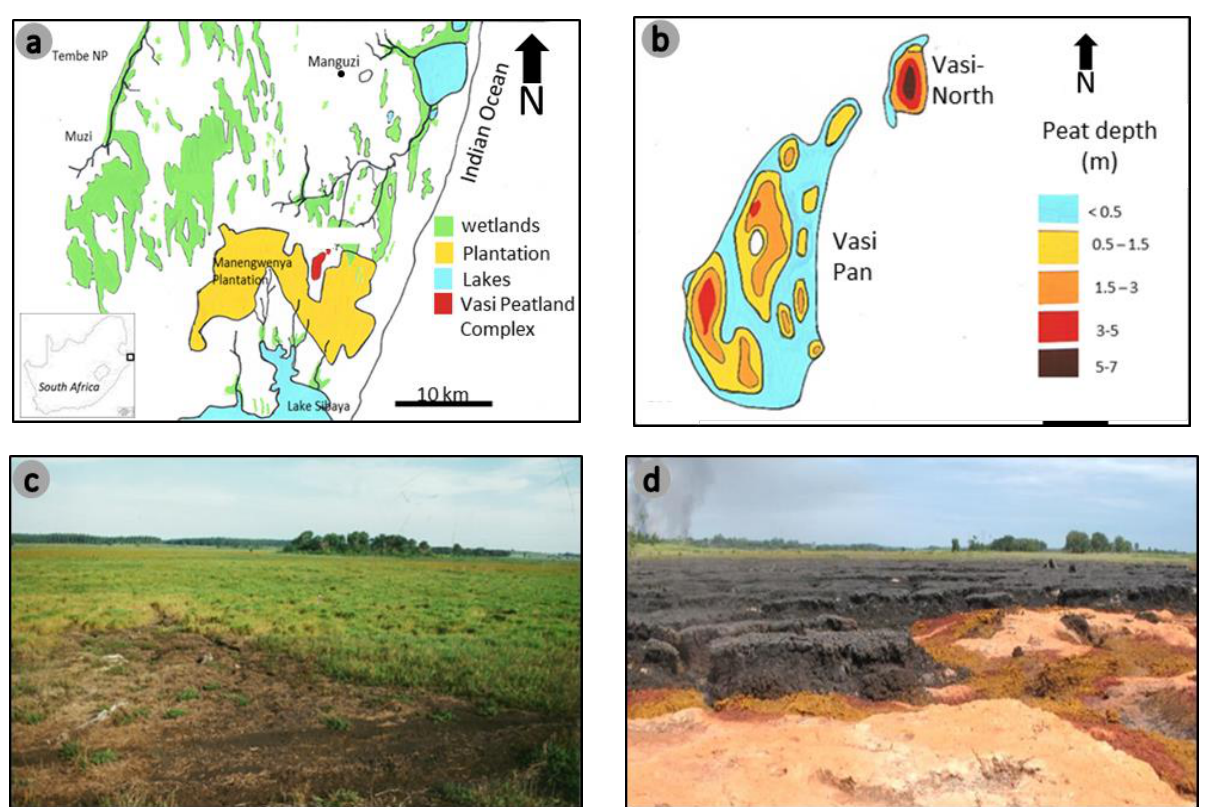
Figure 1. (a) Location of the study area: Vasi peatland complex (red), north of Lake Sibaya in KwaZulu- Natal, South Africa. The Vasi peatland complex is surrounded by the Manzengwenya plantations (yellow). (b) Peat depths in the Vasi peatland complex (source: Grundling & Blackmore 1998). (c) A photograph of one of the basins in Vasi Pan taken in 1998, with the (green) vegetation cover mostly intact. (d) A photograph of the same basin in March 2014. The vegetation cover has disappeared, 30–40cm of the peat has turned into ashes with widened fissures in between, and there are some indications of old spring sites which can be identified by the orange/brown colour of iron